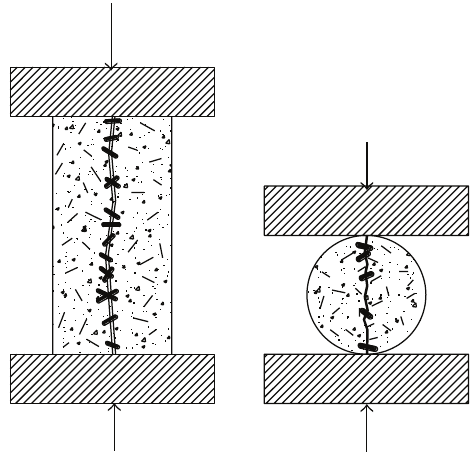
Figure 1: Crack bridging of SFRC by steel fibers in compression and splitting tension test of cylinder